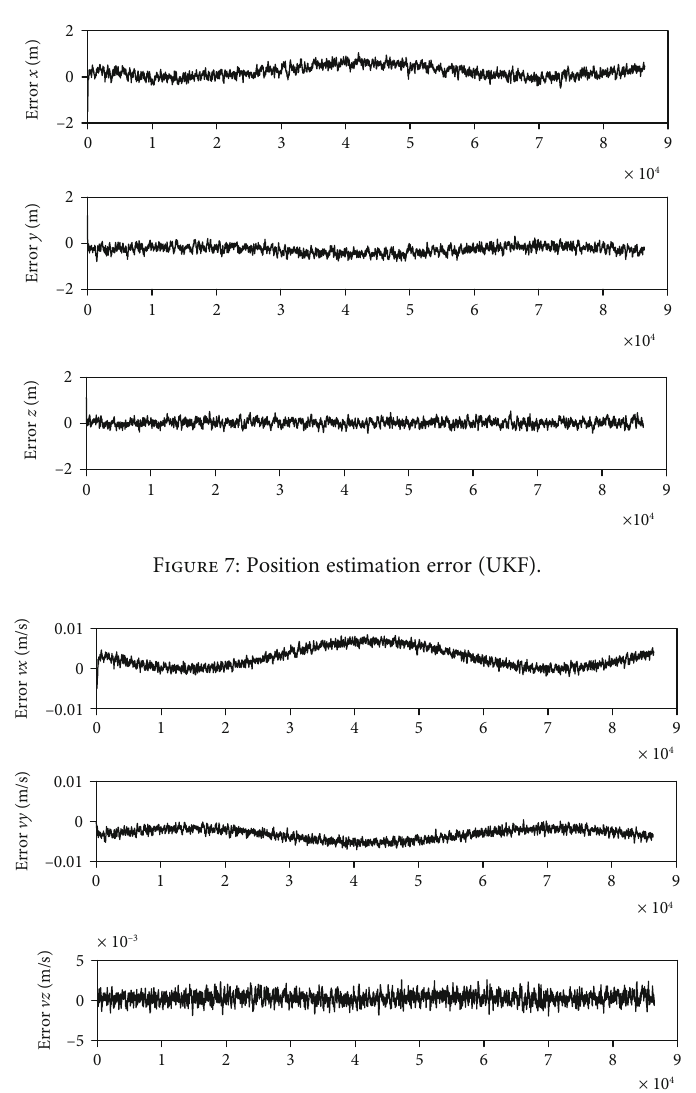
Figure 8: Velocity estimation error